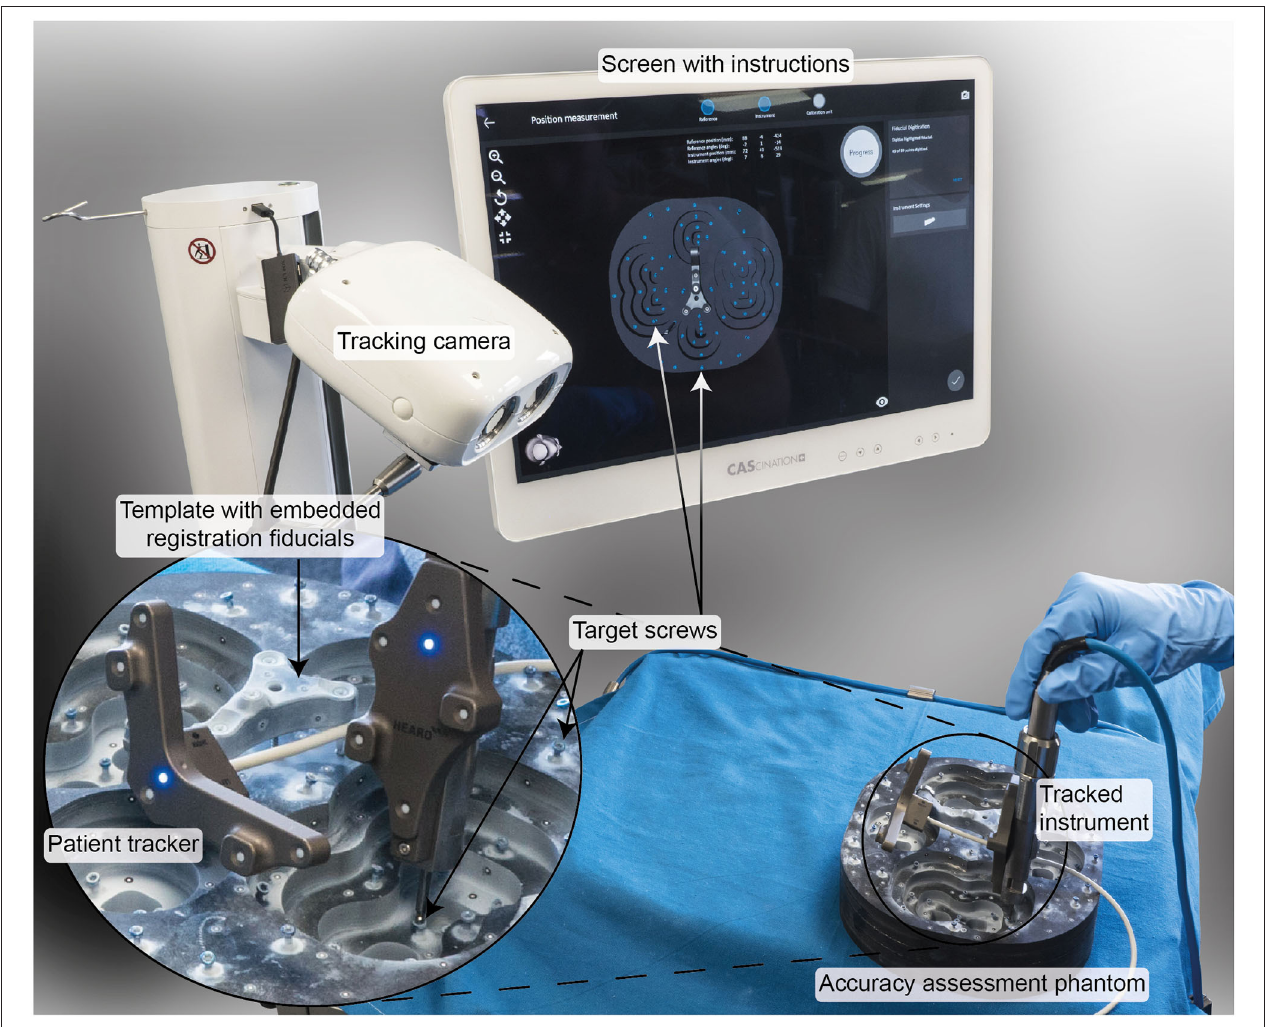
FIGURE 2 | Experimental setup to preclinically verify a TRE < 0.5mm ( µ TRE + 3 σ TRE ). A task-specific phantom made of carbon fiber and measured using a coordinate measurement machine with a measurement error < 0.015mm was used. The user was guided by the software through the registration and measurement